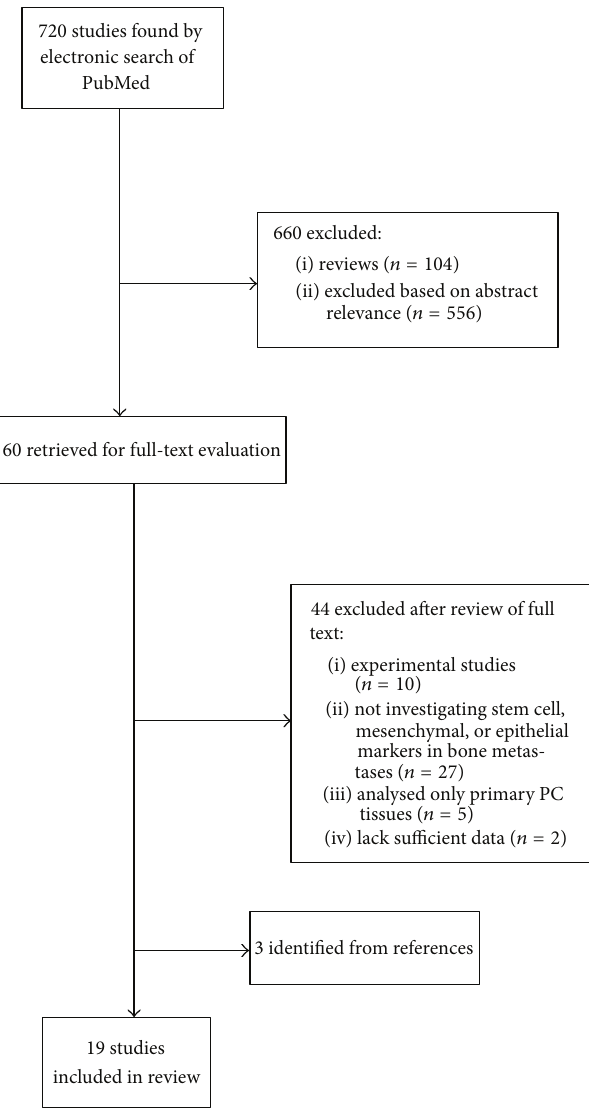
Figure 1: Flow chart of search strategy and study